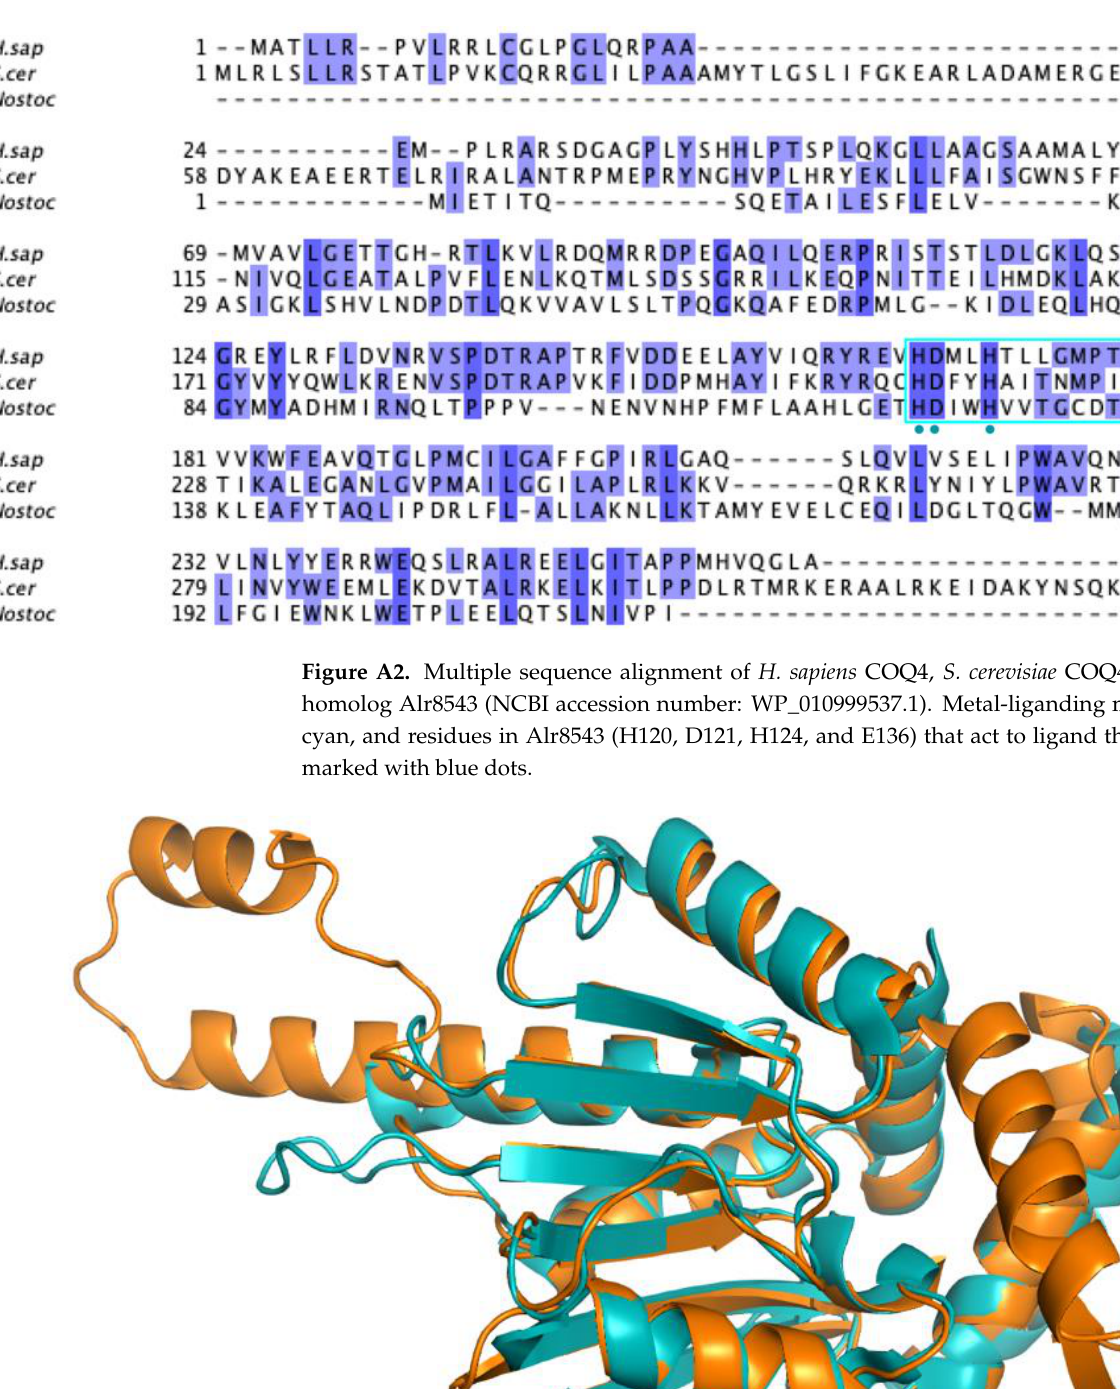
Figure A4. AlphaFold model of single chain of COQ9. Model color corresponds to the model confi- dence described in Figure 4. Figure was generated by the AlphaFold Protein Structure Database [39,54]. References 1.